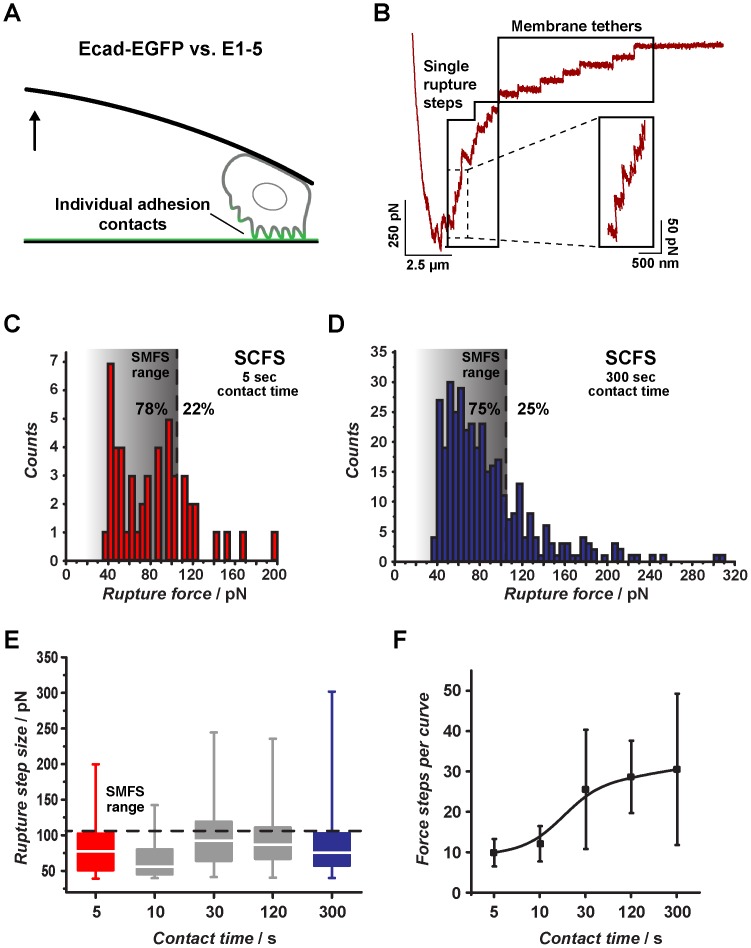
Rupture force step analysis in SCFS experiments.(A) A single L-cell expressing Ecad-EGFP is approached onto an E1-5 surface. During substrate contact individual cadherin adhesion contacts form progressively. (B) During subsequent cell retraction, individual contacts rupture sequentially, leading to a step-like signature in the force-distance curve. Cytoskeleton-attached receptor bonds rupture under active force loading (single rupture steps, zoom-in), while membrane tethers are extracted under constant force, indicted by a plateau in the force curve before bond rupture. A plateau length cut-off of 300 nm was used to separate single rupture steps from tethers. (C) Single rupture step histogram after a contact time of 5 s. The dotted line indicates an arbitrary force threshold which contains <95% of single cadherin unbinding forces determined in SMFS measurements. The percentage values indicate the fraction of single rupture steps falling below (on the right) or above (on the left) the single-molecule force threshold. (D) Single rupture step histogram after 300 s. The percentage values indicate the fraction of single rupture steps falling below (on the right) or above (on the left) the single-molecule force threshold. (E) Rupture step sizes versus contact time as box-whisker-plots. The dotted lines indicate the same single molecule force threshold as in (C) and (D). (F) Number of single rupture steps (±SD) per force-distance-curve for different cell-substrate contact times. A trend line highlights the increase in rupture force step number per force curve with increasing contact time.